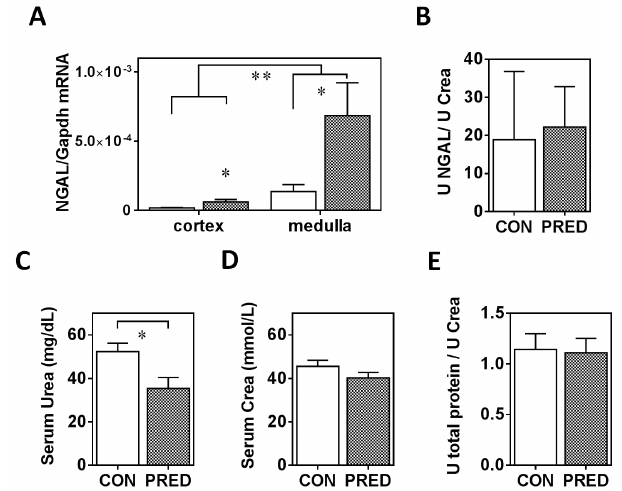
Figure 4. Parameters of renal function and renal injury at the end of the study. ( A ) Lcn 2 ( NGAL ) mRNA expression in the kidney cortex and medulla, ( B ) urine Lcn 2 excretion ( C ) plasma urea (mg/dL) and ( D ) plasma creatinine concentrations (mmol/L), ( E ) urinary protein excretion in obese prediabetic (PRED, grey columns) and control (CON, white columns) rats at the end of the study. Data are means ± SEM, n ≥ 7/group two-way RM ANOVA ( A ); and unpaired two-tailed Student’s t-test (B-E); *: p < 0.05, **: p < 0.01.